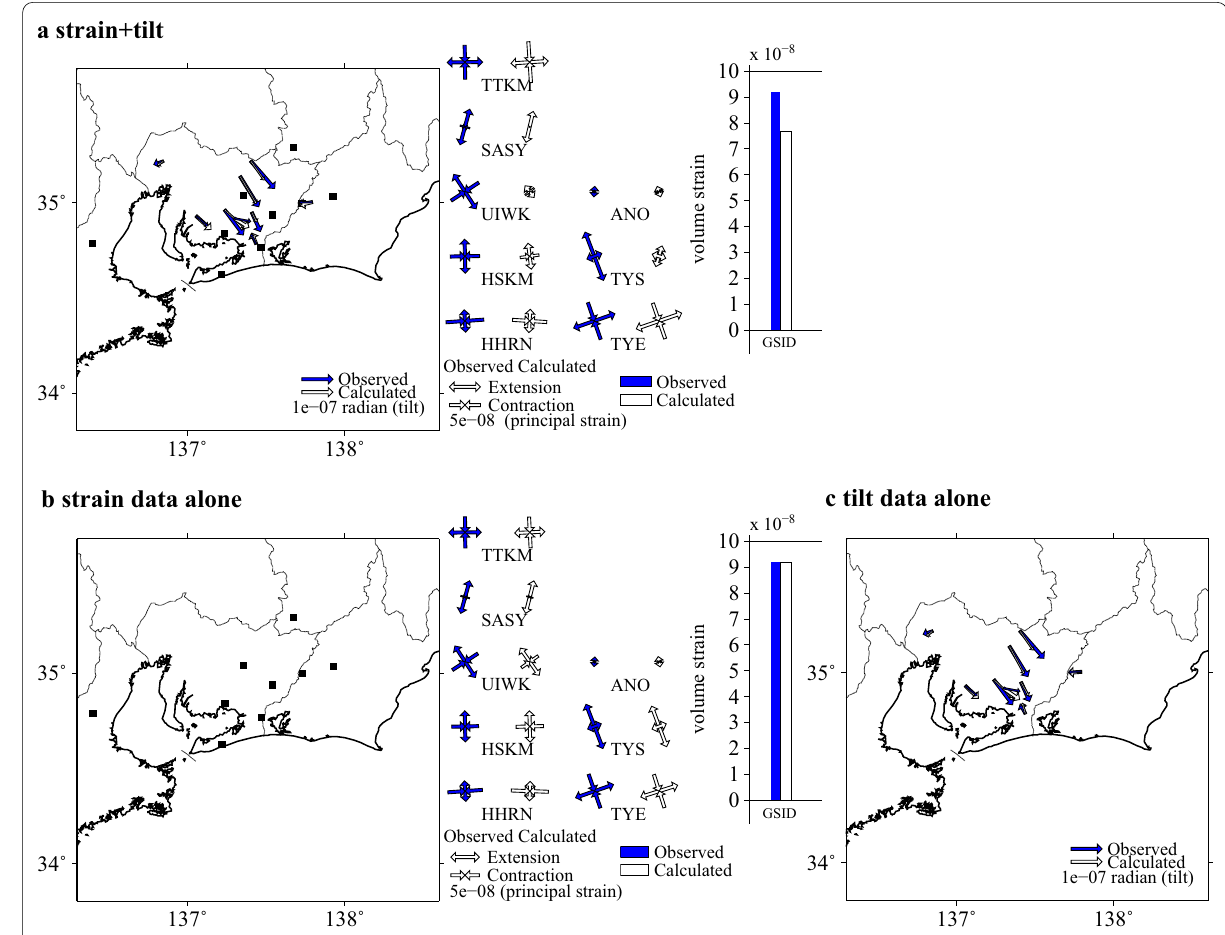
Fig. 9 Observed and calculated strain (right panel) and tilt (left panel) data during 14–19 April 2015. Map region corresponds to Area B in Fig. 1. a Strain data and tilt data from observations (blue) and calculated from the estimated slip distribution shown in Fig. 7a (white). b Strain data from observations (blue) and calculated from the estimated slip distribution shown in Fig. 7b (white). c Tilt data from observations (blue) and calculated from the estimated slip distribution shown in Fig. 7c